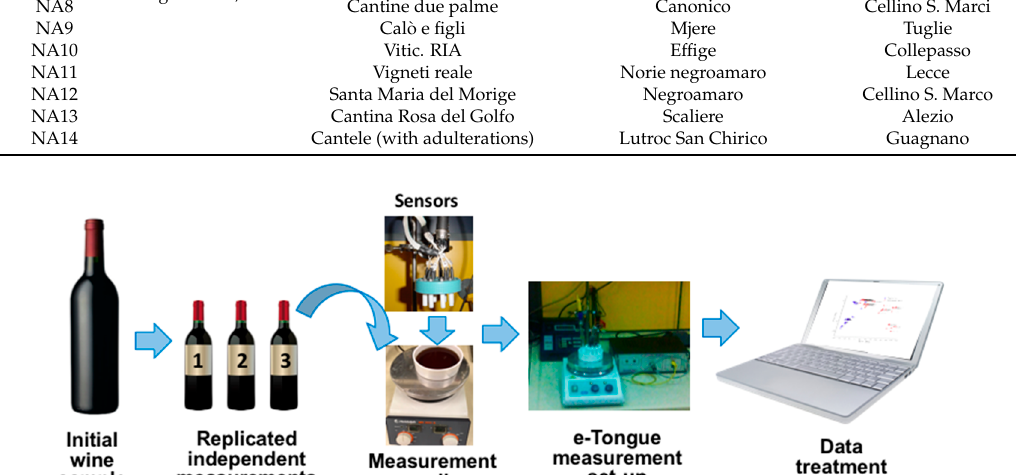
Figure 3. Schematic presentation of the employed measurement